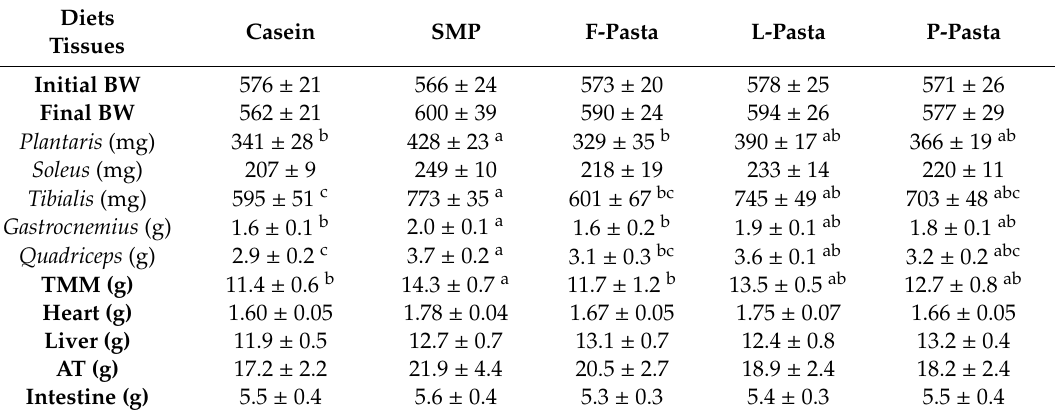
Table 6. Tissue weights in old rats after six weeks of